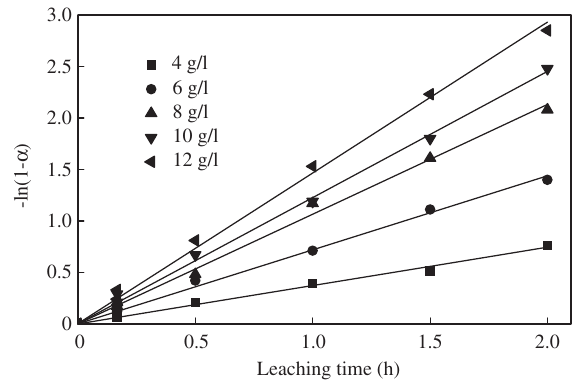
Figure 8: The variation in -ln(1- α ) with time for different thiourea concentrations. Table 2: Rate constants at different temperatures ( k correlation coefficients.